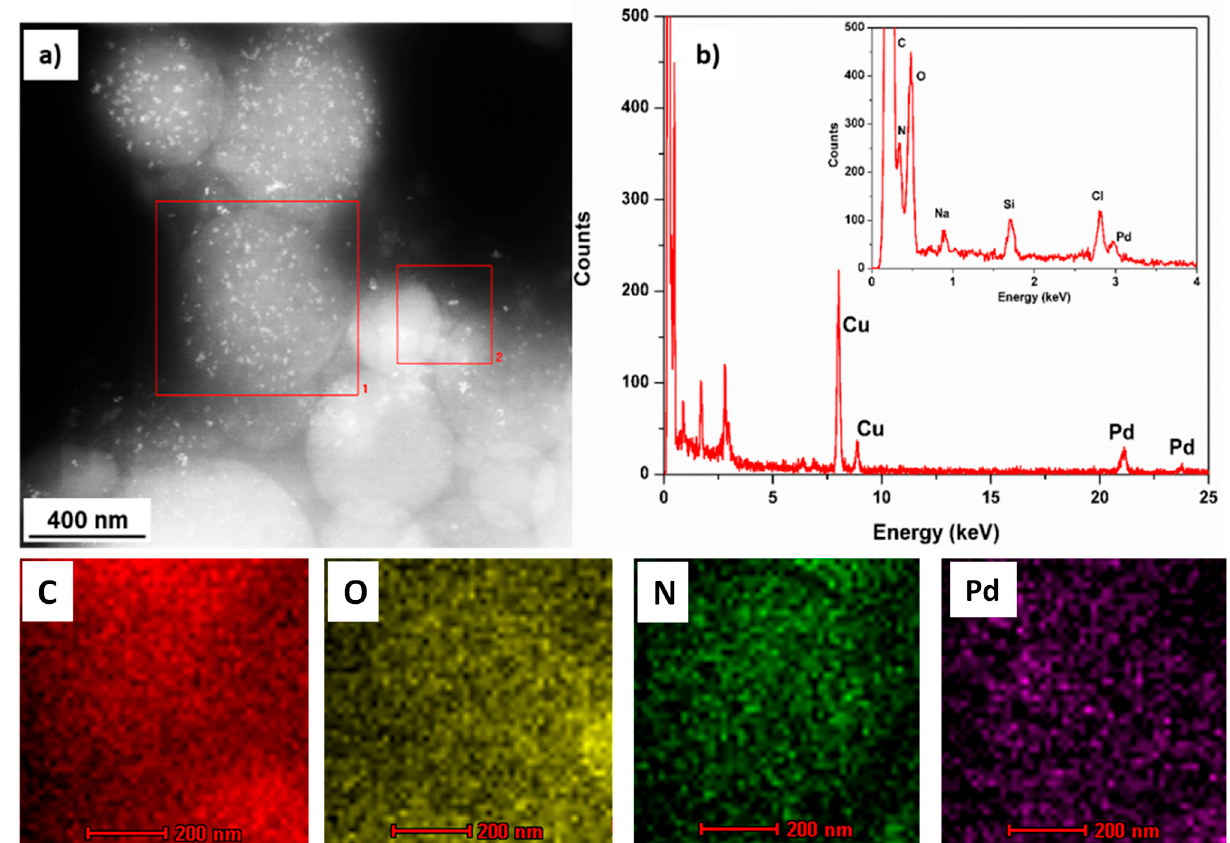
Figure 5. STEM mode applied for the ( a ) mapping and ( b ) energy dispersive X-ray spectroscopy (EDXS) analyses of the Pd NPs /PEG 200 @PU MCs.